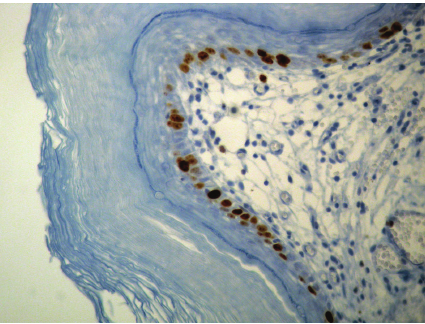
Figure 4: The proliferative activity is limited to the basal layer of the squamous epithelium as highlighted by Ki-67 immunohistochem- istry (D.A.B./Hematoxylin, ×